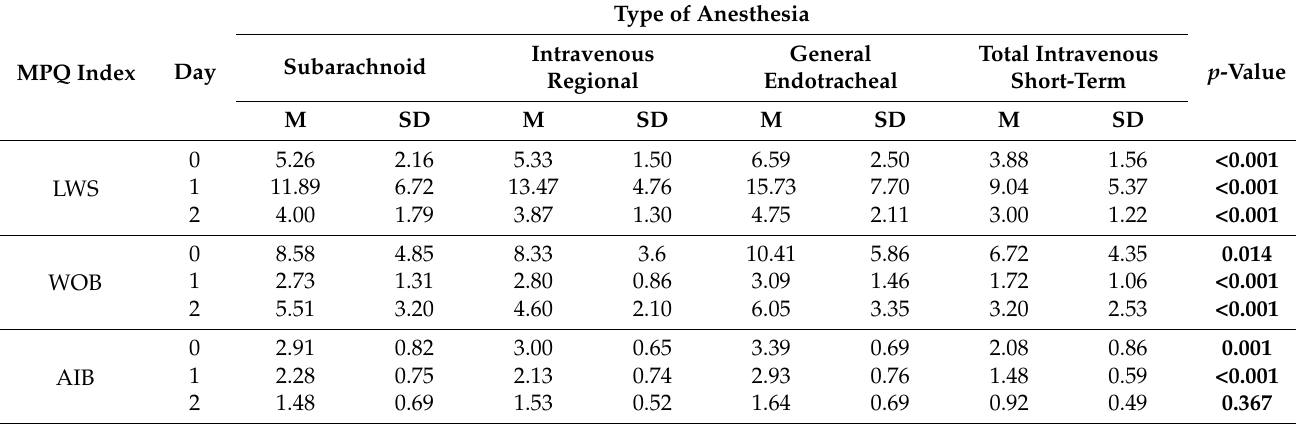
Table 2. Effect of anesthesia on the intensity of postoperative